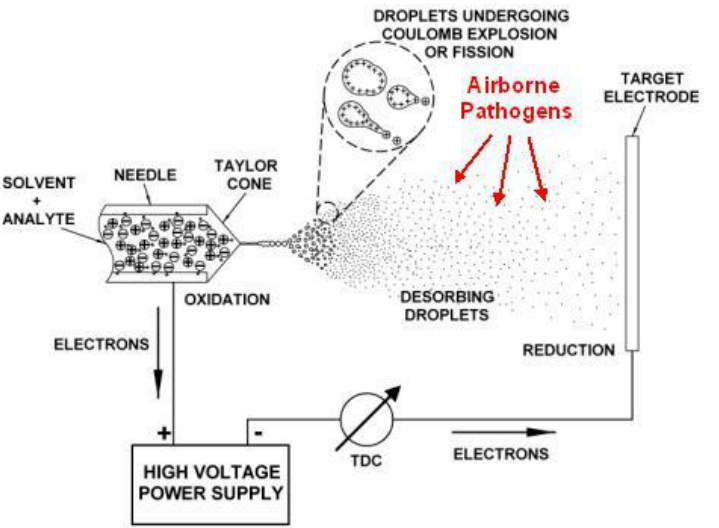
Figure 2. Mechanism for electrospray pathogen capture from ambient air. A conductive needle containing a polar solvent and a conductivity enhancer is subjected to an electric field that produces a Taylor Cone. An emerging jet fragments into fine highly charged desorbing solvent droplets that attract and capture ambient respiratory droplets containing pathogens. Charged droplets with pathogens are then deposited onto the electrode target.